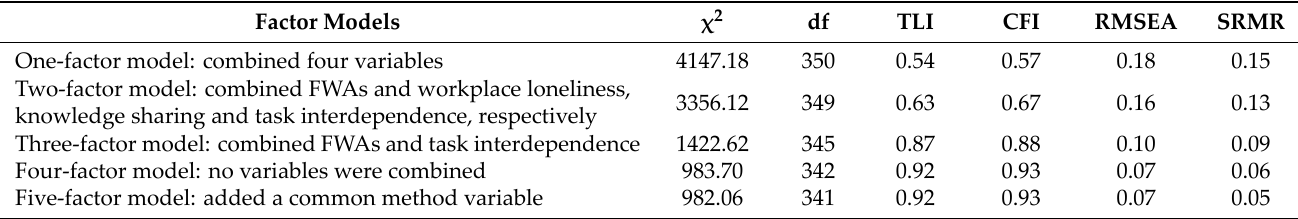
Table 4. Confirmatory factor analyses of Study 2.